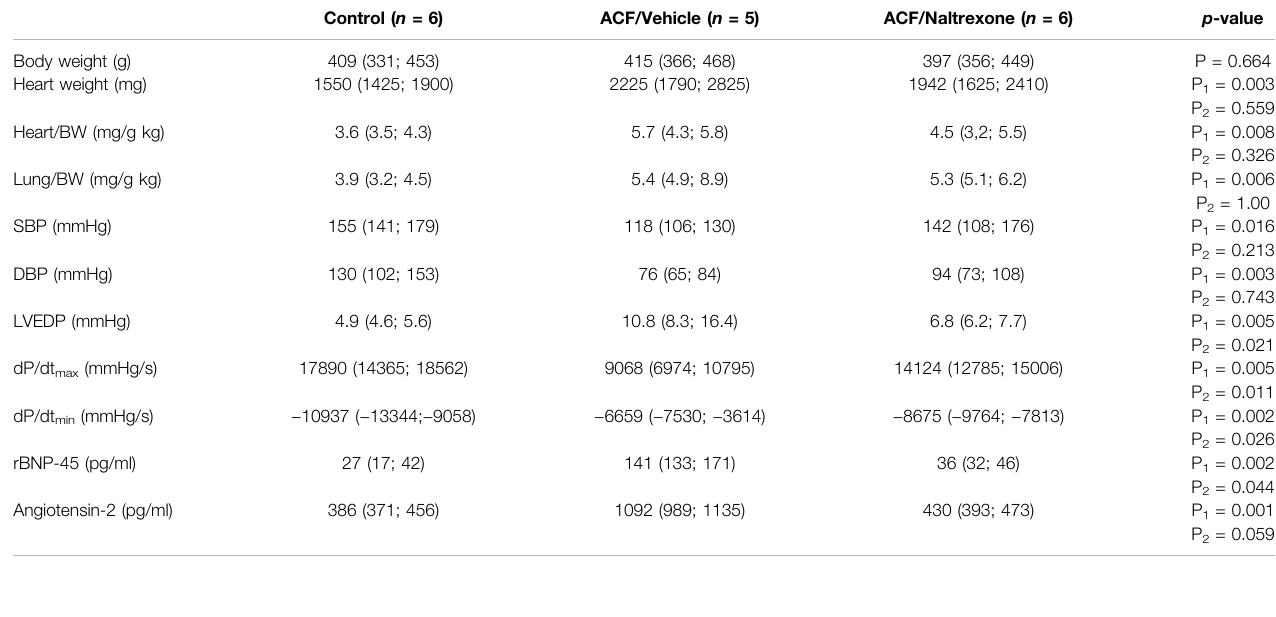
TABLE 1 | Changes of morphometric and hemodynamic parameters of the weight indices of heart and lung in relation to body weights and biventricular fi lling pressures obtained from control rats and vehicle- (isotonic saline) or naltrexone-treated rats with ACF-induced volume overload. The data are given as medians plus interquartile ranges: HR = heart rate; SBP = systolic blood pressure; DBP = diastolic blood pressure; BW = body weight. Note that there are signi fi cant differences not only between the ACF/Vehicle and control group (P1-value) but also between the ACF/Vehicle and ACF/Naltrexone group (P2-value). p < 0.05 was considered statistically signi fi cant.